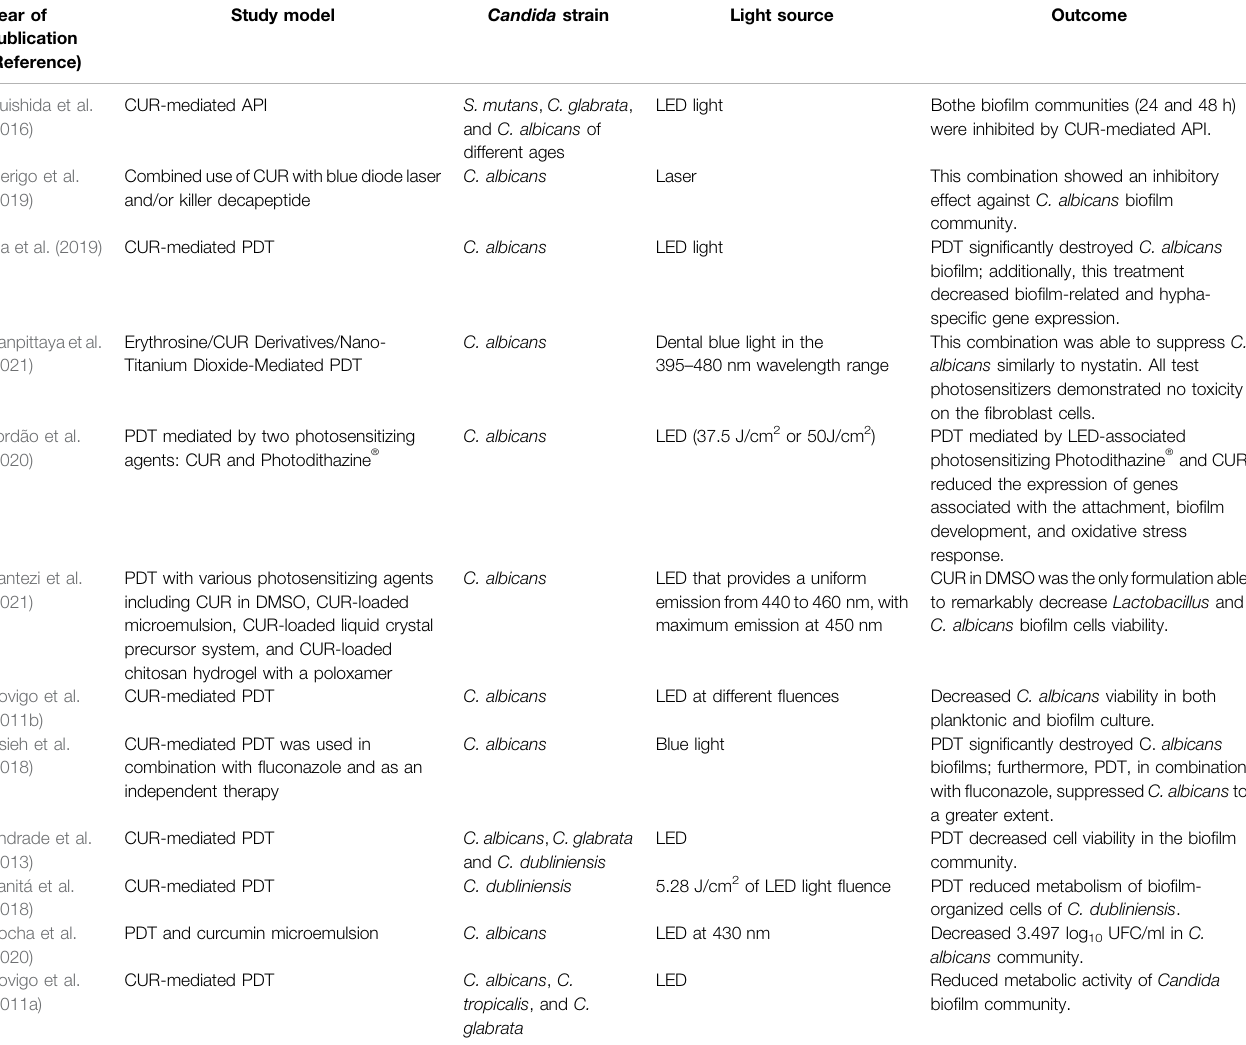
TABLE 1 | Studies that have applied a combination of photodynamic therapy and curcumin for the elimination of Candida bio fi